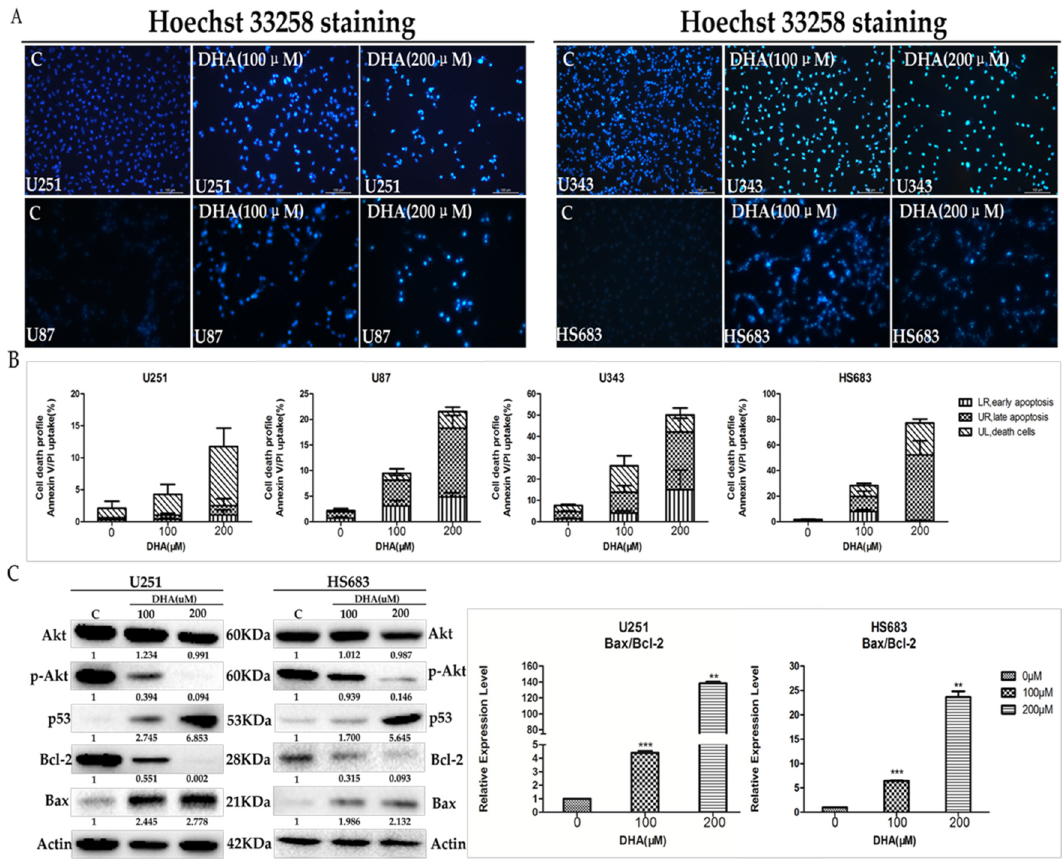
Figure 1. Effect of DHA on malignant glioma cells’ apoptosis by regulating AKT axis. The indicated Figure 2. Effect of DHA on malignant glioma cells apoptosis by regulating AKT axis. The indicated cells were treated with 100 and 200 μ M DHA for 48 h. ( A ) Cells stained with Hoechst 33,258 were cells were treated with 100 and 200 µ M DHA for 48 h. ( A ) Cells stained with Hoechst 33258 were detected and calculated by fluorescent photomicrographs at 10×. Scale bar = representative results detected and calculated by fluorescent photomicrographs at 10 × ; ( B ) cells were labeled with Annexin V/Propidium Iodide (AnnexinV/PI) and detected by flow cytometry. Values were mean ± SD ( n = 3); ( C ) the proteins associated with AKT/p53/Bcl-2/Bax axis in malignant glioma cells were determined by western blot analysis. The changes of Bax/Bcl-2 ratio were evaluated by western blot analysis. Values were mean ± SD ( n = 3). ** p < 0.001, *** p < 0.0001 as compared with negative control